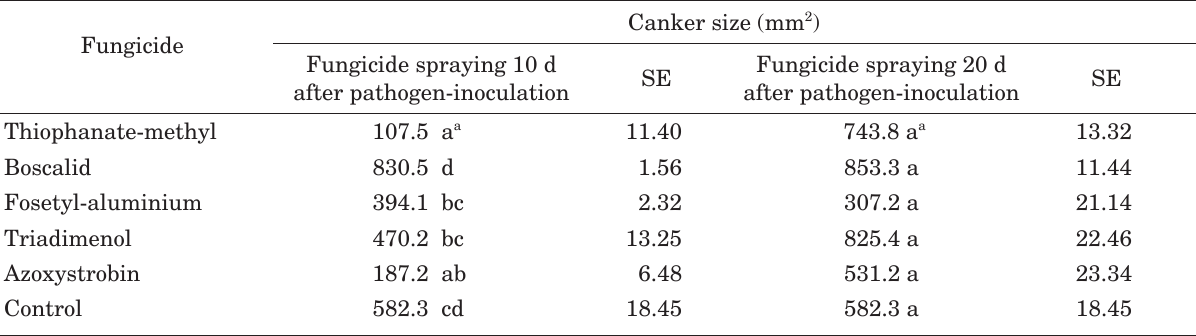
Table 5. Post-inoculation spraying. Mean area of cankers measured on the stems of Cupressus sempervirens saplings 4 months after inoculation with Seiridium cardinale . Plants were sprayed with fungicides 10 or 20 days after being inoculated. Mean values with different letters within each column were significantly different ( P <0.01) according to the AnOVA one-way HSD